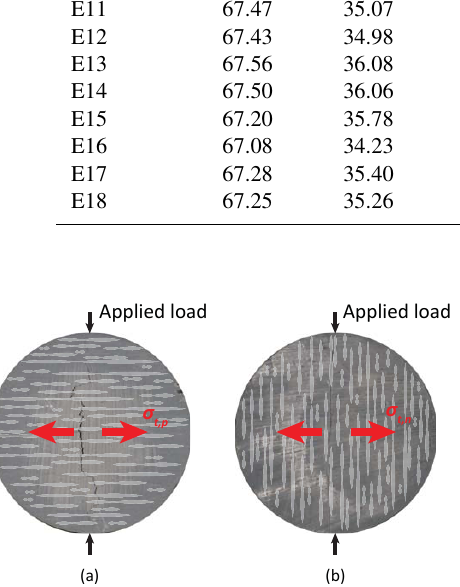
Figure 4. Loading configuration for the Brazilian tests with respect to bedding (bedding orientation is indicated by the light grey pat- tern). In panel (a) the load is applied normal to bedding, allowing the measurement of the Brazilian tensile strength parallel to bedding ( σ t , p ) . In panel (b) the load is applied parallel to bedding, allowing the measurement of the Brazilian tensile strength normal to bedding ( σ t , n )